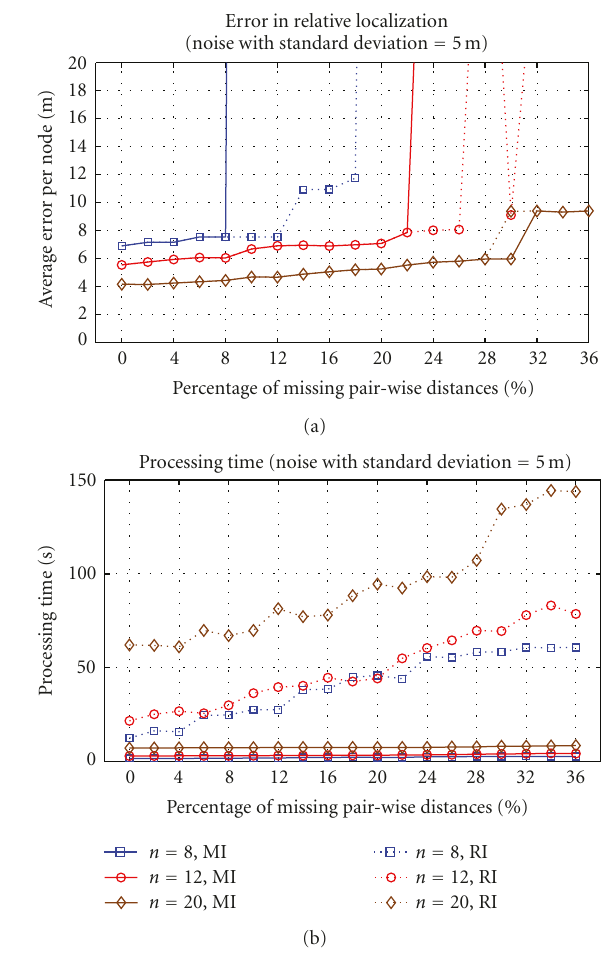
Figure 3: (a) Error performance; (b) processing time versus percentage of missing pairwise distances (where the larger distances are made missing) using ideally measured distances.